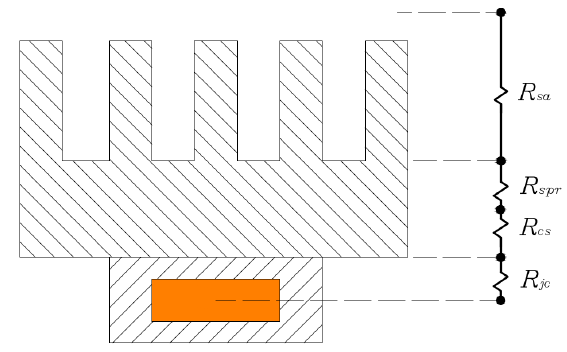
Figure 2. Scheme of the thermal resistance network of the considered heat sink.